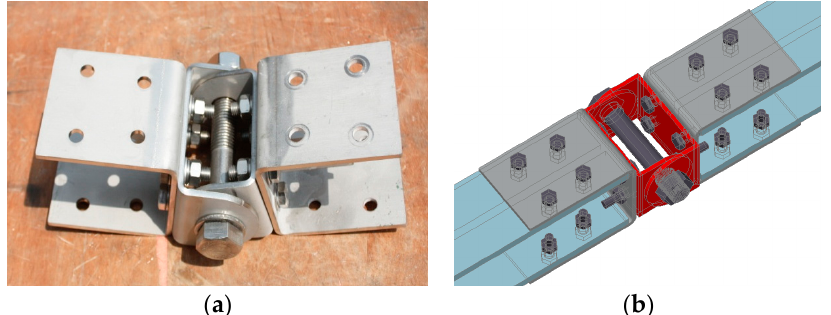
Figure 6. Connection system between unit structures; (a) C-shape device; (b) Member connected with C-shape device.